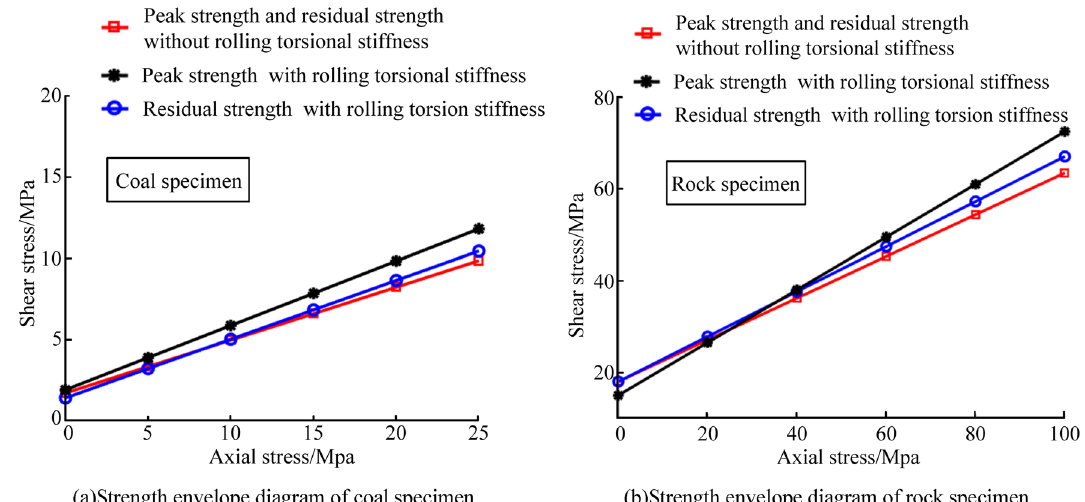
Figure 8. Strength envelope diagram.